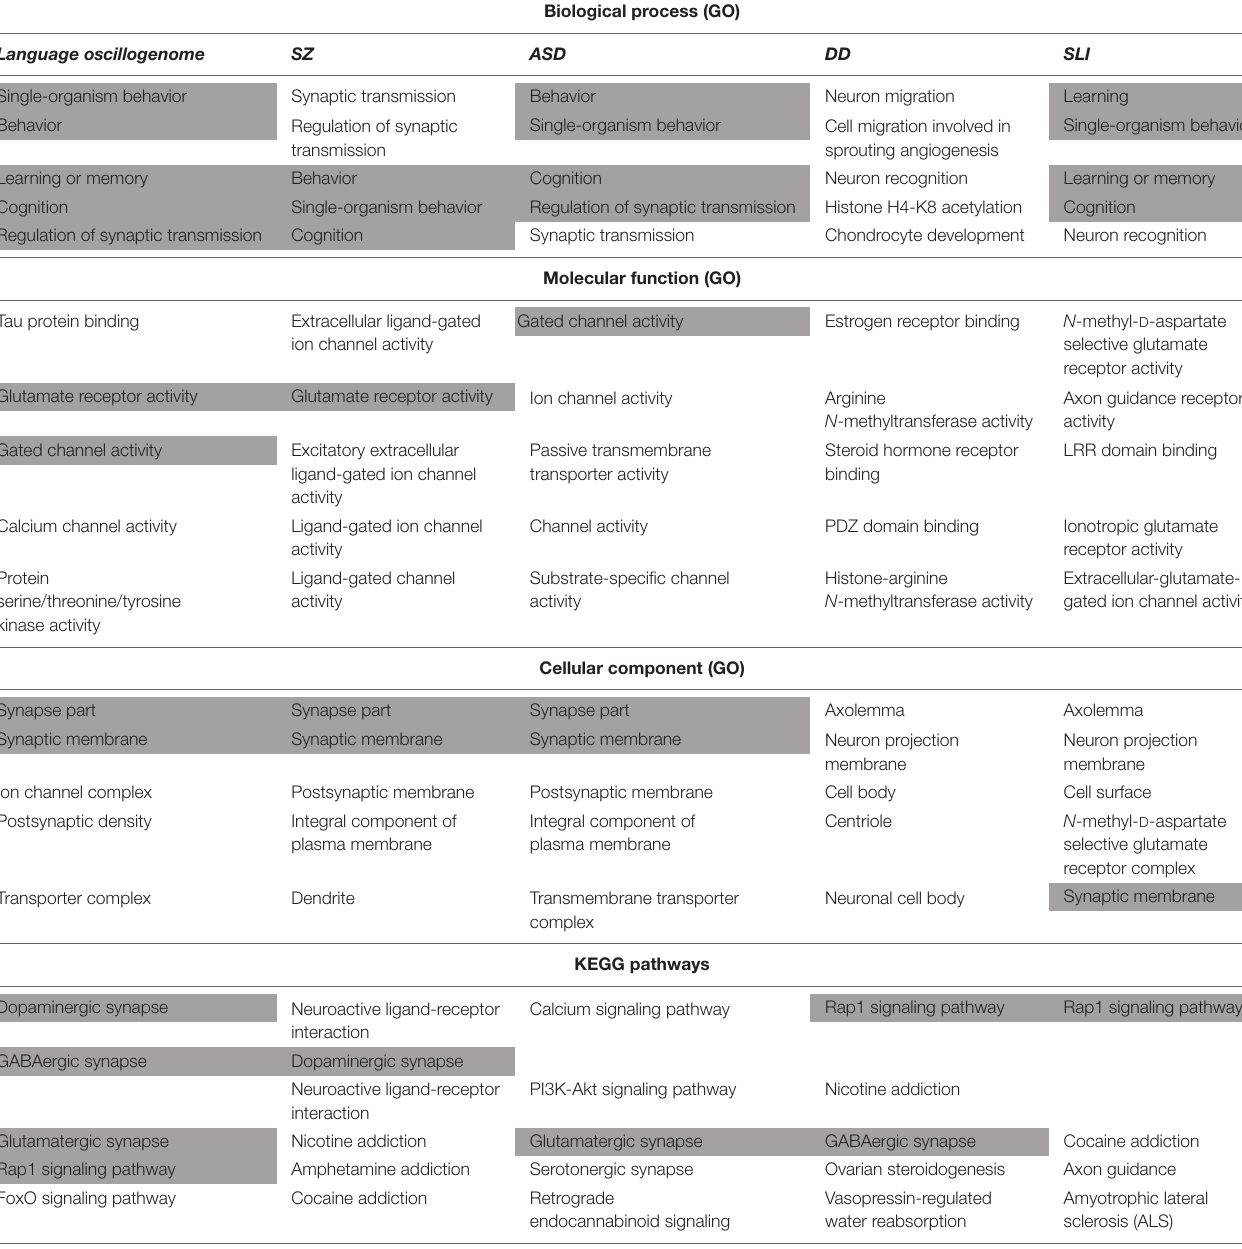
TABLE 3 | Comparison of the functional enrichment of candidates for the oscillogenome SZ, ASD, DD, and